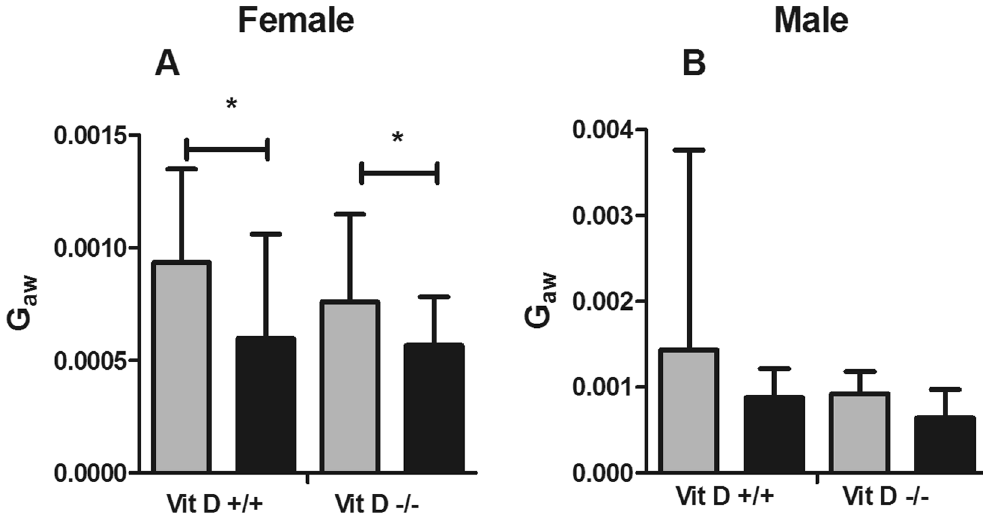
Figure 5. Airway distensibility, calculated as the slope of the conductance (G aw = 1/R aw ) versus pressure curve between 2 and 10 cmH 2 O Prs, for female ( A ) and male ( B ) vitamin D replete (Vit D + / + ) and vitamin D deficient (Vit D − / − ) mice exposed to 25 µ g of HDM in 50 µ L intranasally for 10 days (black bars) or saline alone (grey bars). Data are presented as mean (SD), n = 7–10 for each group in female and 8–12 in male. * p <